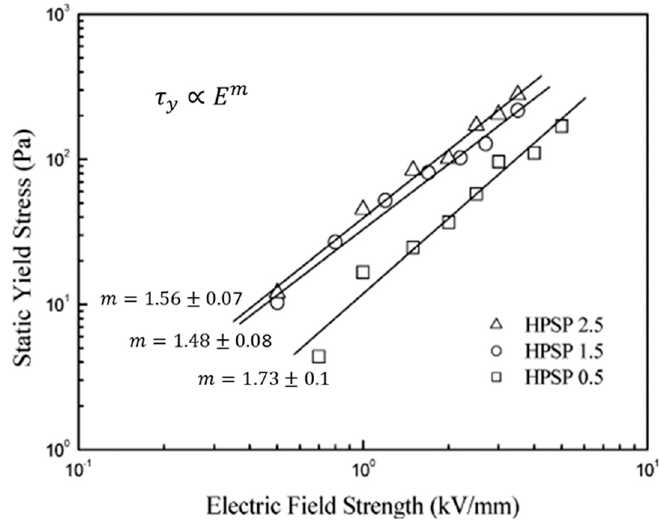
Figure 13. Yield stress vs. electrical field strength for highly substituted potato starch phosphate (HPSP)-based ER suspension with different molar ratios, reprinted with permission from [124]. Copyright American Chemical Society, 2005.